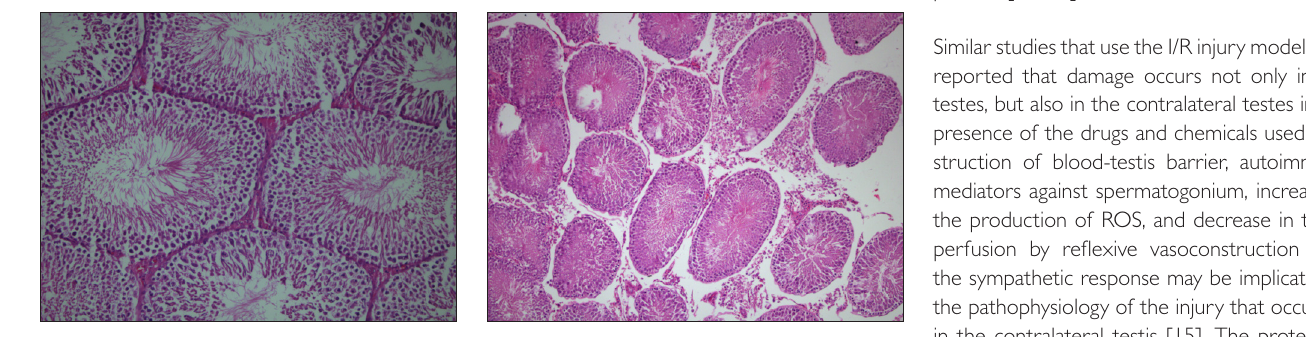
Figure 3. Edema and inflammatory cell accumulation in the interstitium,